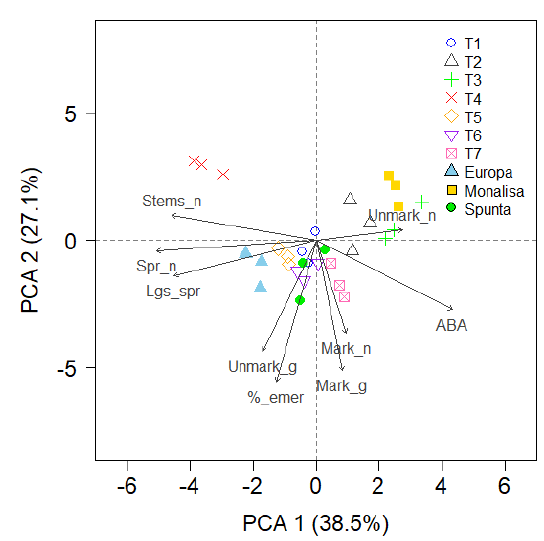
Figure 3. Principal component analysis (PCA) biplot showing patterns and interaction between variables and treatments for Experiment 1. ABA, abscid acid content; Sprout_n, number of sprouts per tuber; Lgst_sprout, the longest sprout; %_emer, percentage of plant emergence; Mark_g, grams of tuber per plant; Mark_n, number of tuber per plant; Unmark_g and Unmark_n, grams and number of unmarketable tuber per plant, respectively. T1: 20 °C; T2: 10/20 °C; T3: 2/20 °C; T4: 38/20 °C; T5: 20 °C + GA 3 ; T6: 10/20 °C + GA 3 ; T7: 2/20 °C + GA 3 .